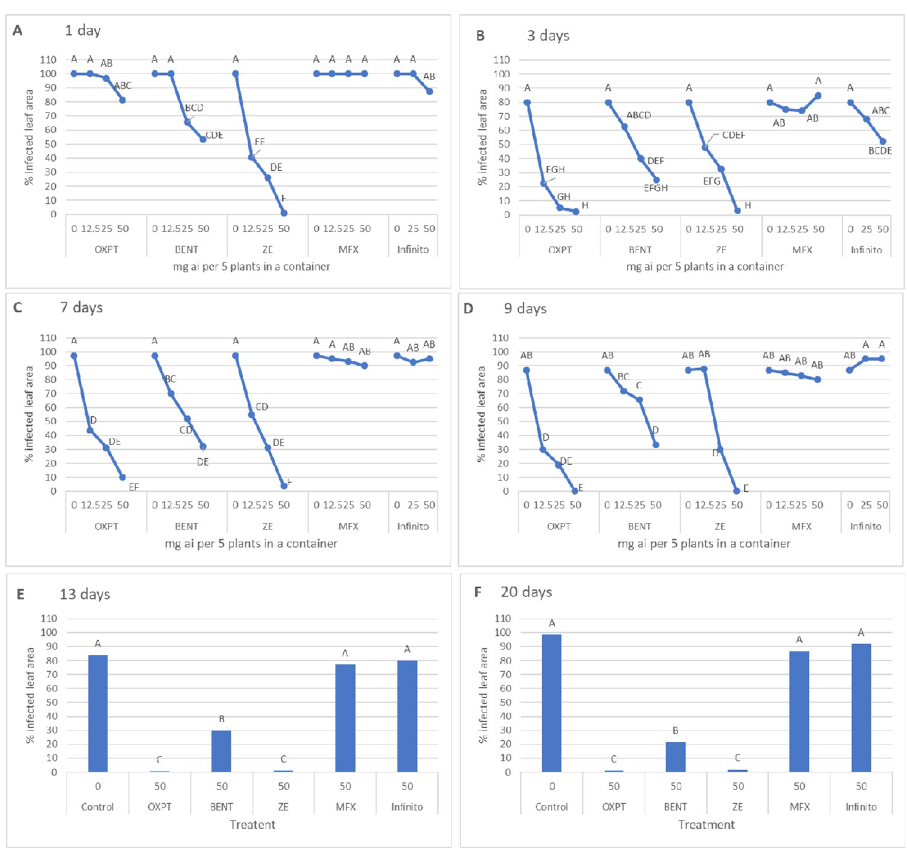
Fig 1. Systemic protection of potato Nicola against late blight by each of five fungicides applied to the soil. Six- weeks old potato plants growing a 64 L container were treated with a single soil-drench of 1L fungicide suspension containing 0, 12.5, 25 or 50 mg ai of a fungicide. Leaves (one compound leaf per plant) were detached at 1–20 days after treatment, inoculated with Phytophthora infestans in growth chambers and visually assessed for late blight development at 7 days post inoculation. Different letters on the curves or columns indicate on a significant different between means (n = 3) at α = 0.05.